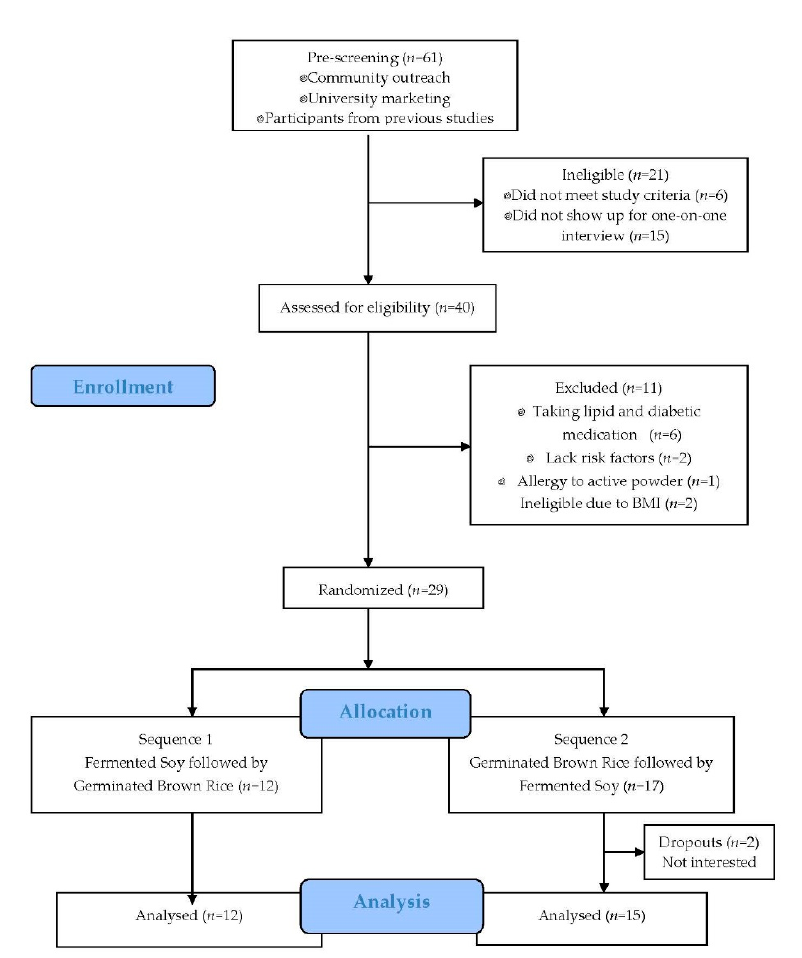
Figure 2. Consolidated standards of reporting trials diagram indicating sample sizes at each stage during the